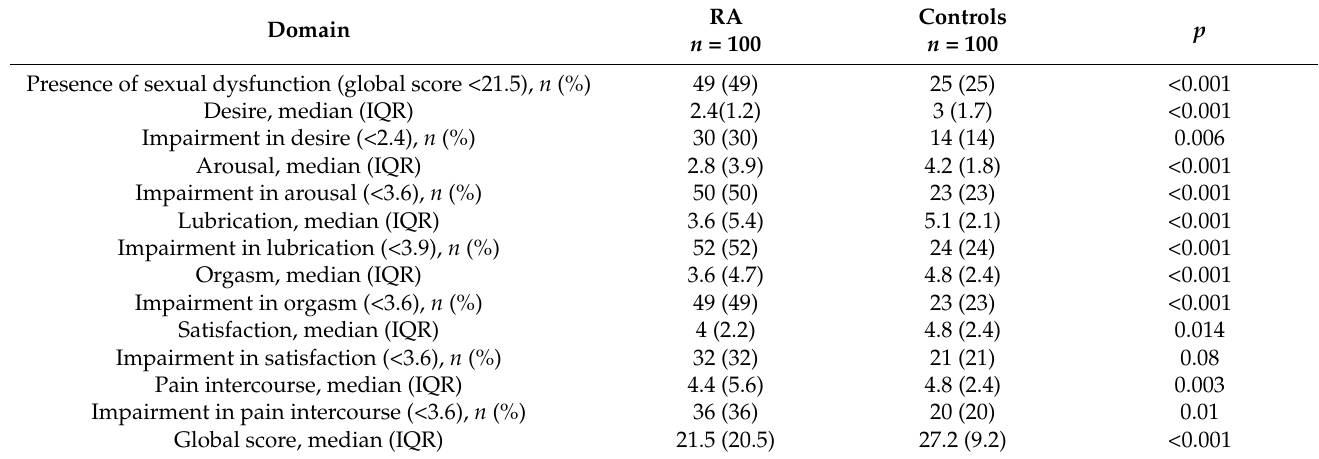
Table 2. Comparison in FSFI score and frequency of sexual dysfunction between patients and controls.